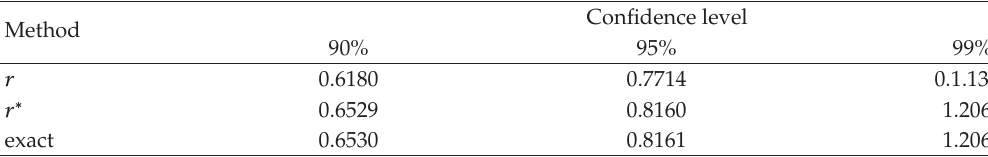
Table 4: Average width of the confidence interval for σ